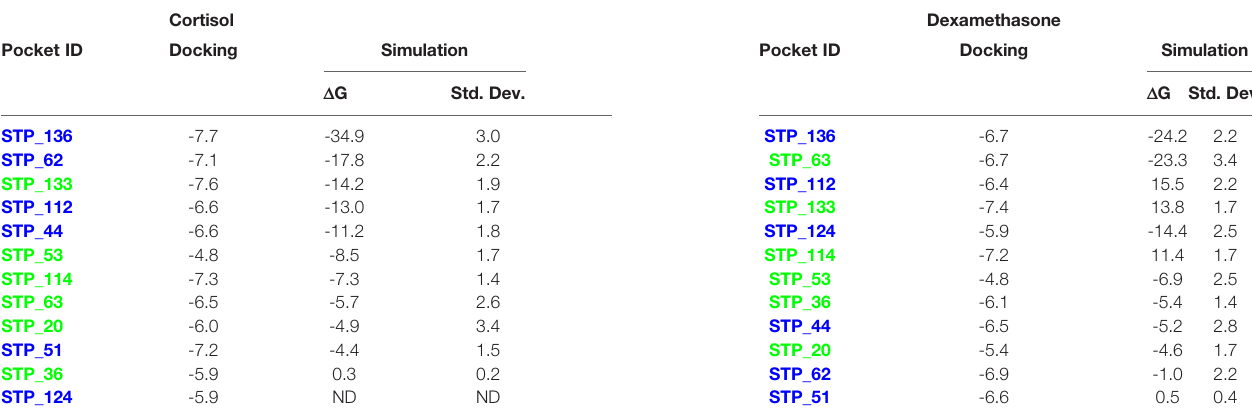
TABLE 3 | Binding energies of cortisol and dexamethasone for each S1 pocket of chain C after docking and MD. Cortisol Dexamethasone Docking